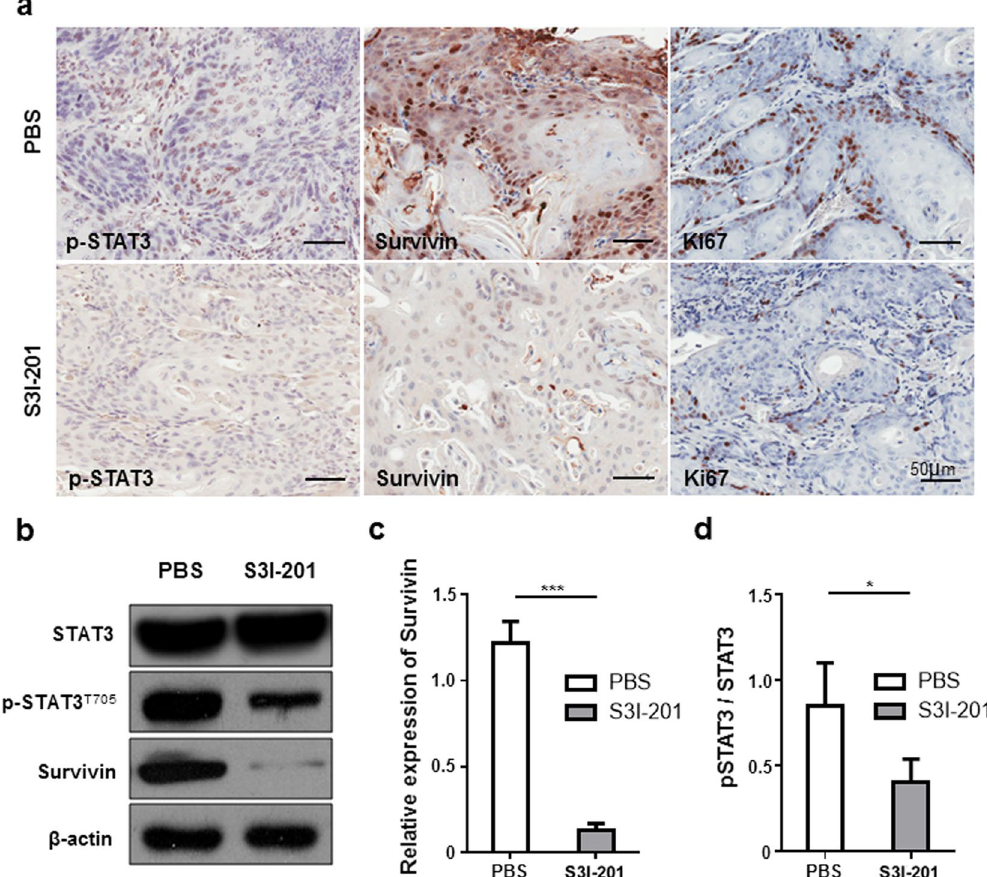
Figure 4. Inhibition of STAT3 reduced the expression of survivin and Ki-67 and induced apoptosis. ( a ) Representative views of the expression of p-STAT3, survivin and Ki-67 in S3I-201 treatment group and control group. ( b ) The expression levels of p-STAT3 and survivin were remarkably reduced after S3I-201 treatment,and their relative quantifications ( c , d ). * P < 0.05; *** P <